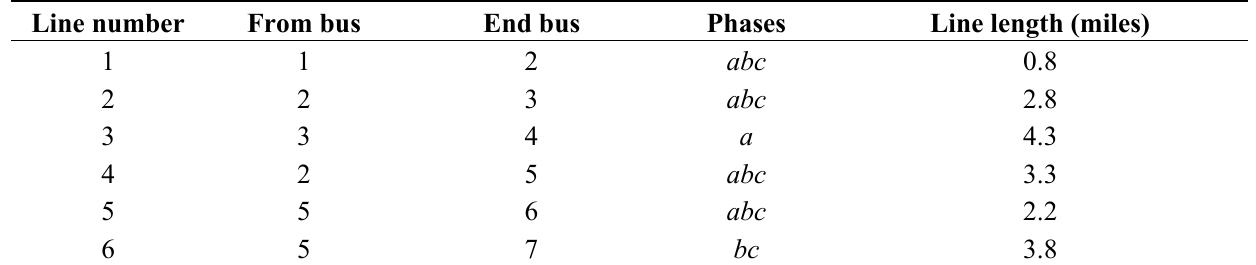
Table 1. Line data of the simple seven-bus test